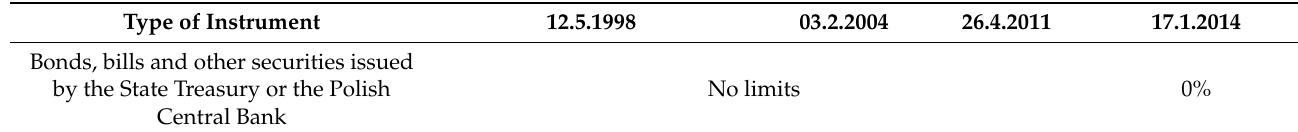
Table 1. Changes to investment limits of Polish pension funds, 1998–2014: Selected instruments. Type of